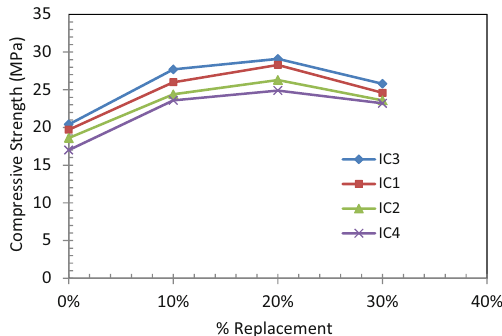
Fig. 6 Effect of percent replacement on compressive strength of control and internally cured samples with w/c ratio of 0.4 under similar curing conditions (Phase